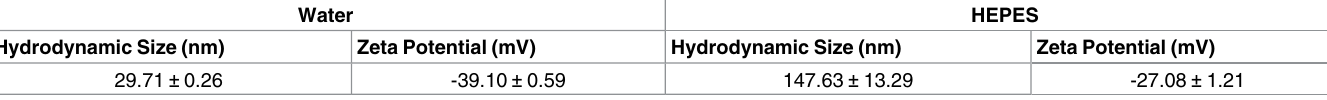
Table 1. Characterization of 20nm citrate-coated AgNPs in water and HEPES